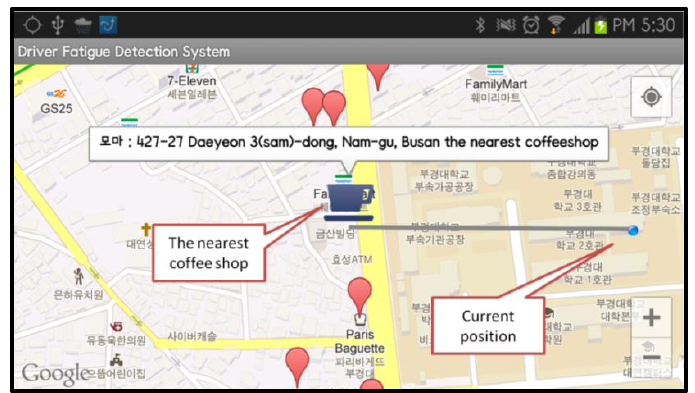
Figure 7. Screenshot of a smartphone that shows a demonstration of the “Searchnearby” service that indicates the location of the nearest coffee shop.